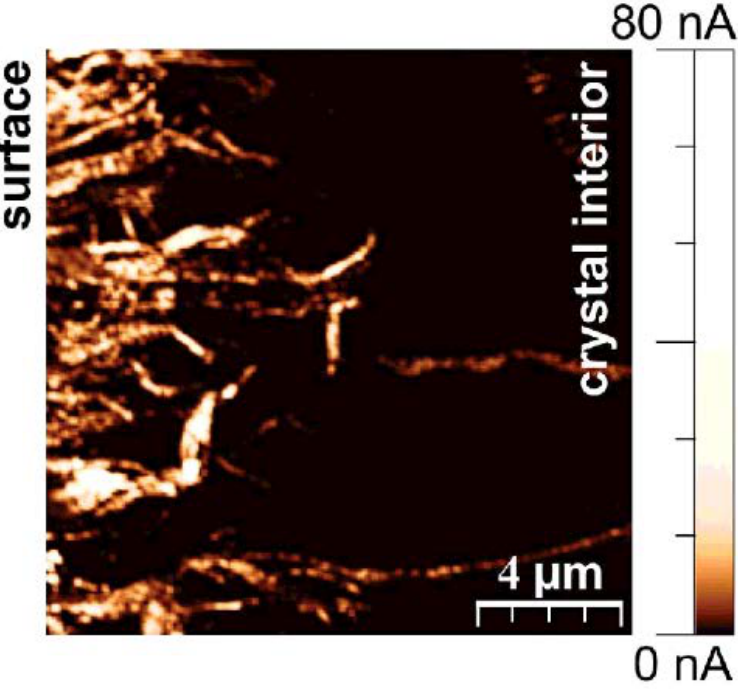
Figure 42. LCAFM on a cross-section of a reduced TiO 2 (110) crystal (adapted from [48]).